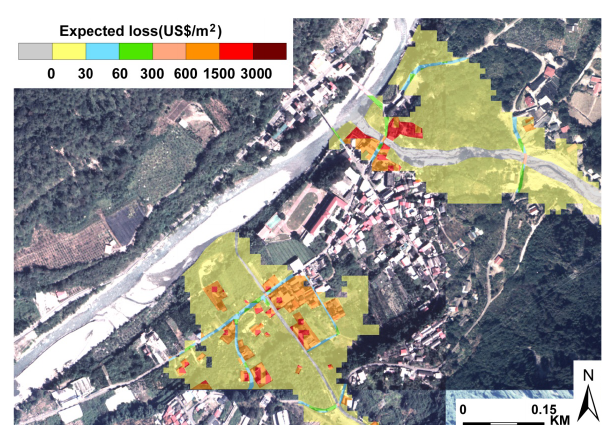
Fig. 7. Map showing the expected total loss caused by debris flows of the Nos. 1 and 2 Torrents for an event with 50-year return period Figure 7. Map showing the expected total loss caused by debris flows of the No. 1 and No. 2 3 after evacuation measures were Torrents for an event with 50-year return period after evacuation measures were implemented.4